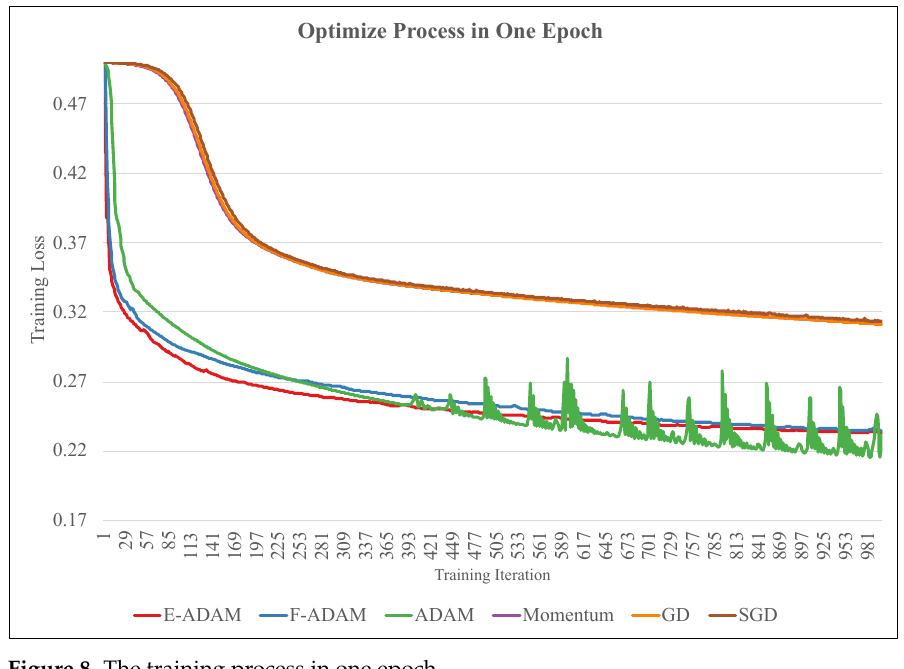
Figure 8. The training process in one epoch.